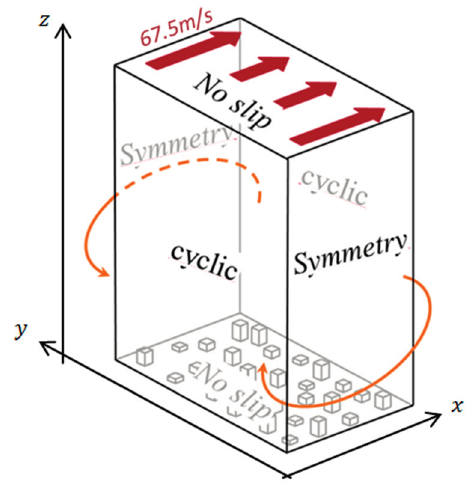
Figure 2. Boundary conditions.